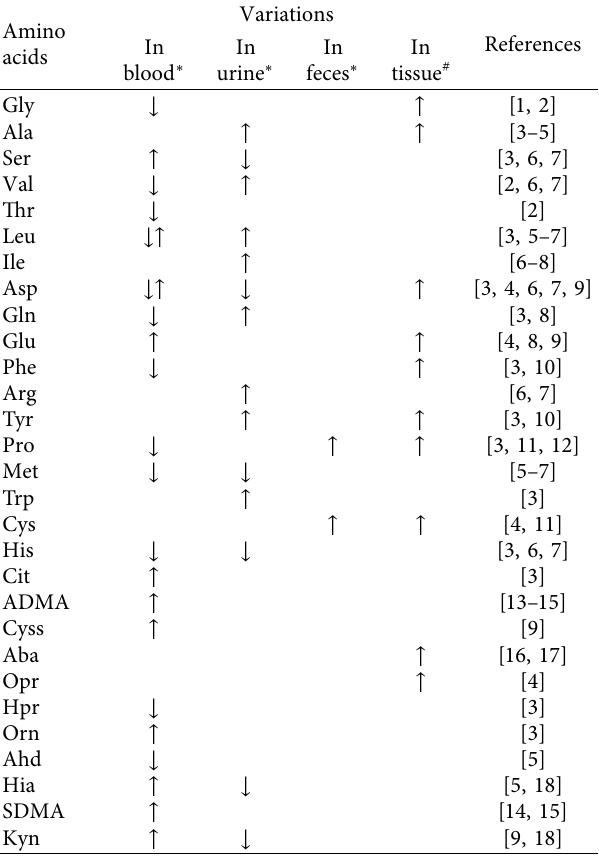
Table 1: The summarized variations of amino acids in blood, urine, feces, and cancerous tissue of CRC patients. Amino acids